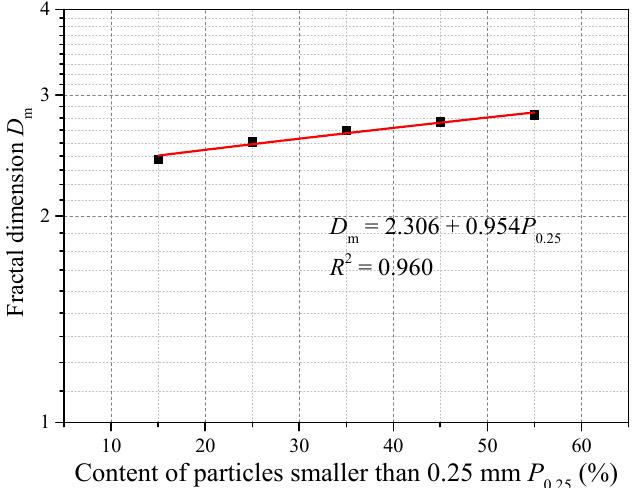
Figure 4. Fractal dimensions of the calcareous sand with different gradation.